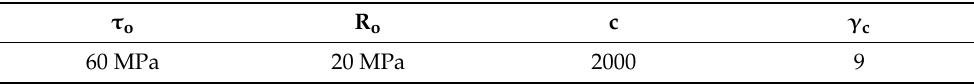
Table 2. Material properties for the model at mesoscopic scale.